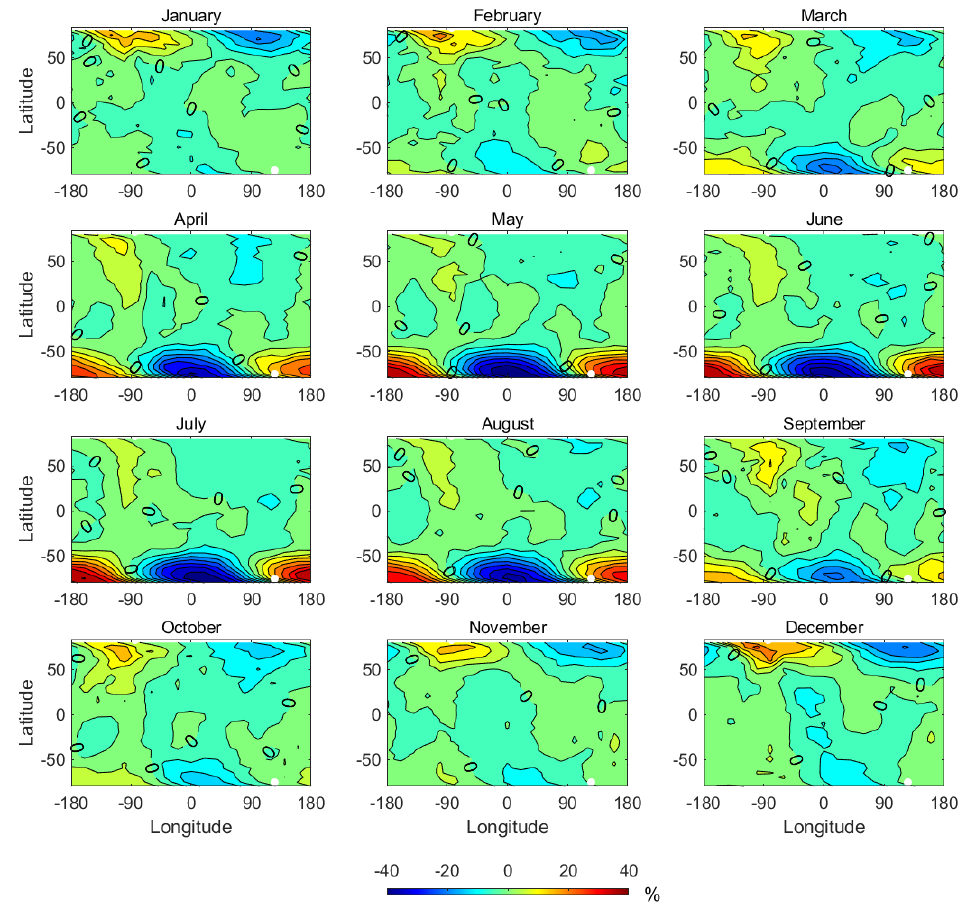
Figure 3. Same as Figure 2 except for the thermospheric densities at 1930 LT (dusk). In Figures 2 and 3, the ∆ ρ rmax maximizes annually at 26.3% and 39.6% in July in the Southern Hemisphere near the geomagnetic pole (~75 ◦ S, ~125 ◦ E) at dawn and dusk, respectively. The annual maximum of ∆ ρ rmax in the Northern Hemisphere appears in Febru- ary and December at dawn and dusk, with values of 15.8% and 25.4%, respectively. The annual maximum in the Southern Hemisphere is much greater than in the Northern Hemi- sphere. The difference in ∆ ρ rmax between the two hemispheres should be mainly caused by the different geomagnetic pole positions relative to the geographic poles. Since the aurora heating is mainly around the geomagnetic pole [25–28] and the southern geomagnetic pole is further off the geographical pole, the effects of auroral heating on the thermosphere in the Southern Hemisphere are harder to cover all longitudes. Thus, the longitudinal variation of thermospheric density in the Southern Hemisphere should be relatively stronger in the Northern Hemisphere under the same other conditions. Xu et al. [10] analyzed the longitudinal variation of thermospheric density using the CHAMP and GRACE satellite observations. Their results showed that the maximal longitude variations averaged for all local times also appear near the geomagnetic poles. Similar to the APOD observations, the CHAMP and GRACE satellite observations showed an apparent hemispheric asymmetry in the longitudinal structure, more pronounced in the Southern Hemisphere than in the Northern Hemisphere. To sum up, the main feature of the global distribution around